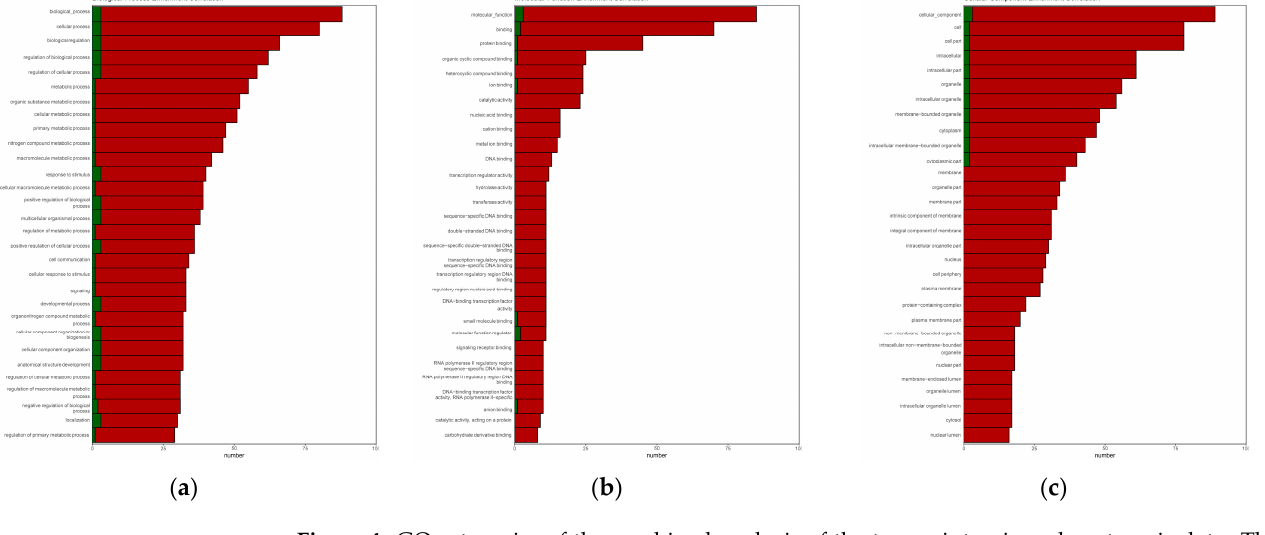
Figure 4. GO categories of the combined analysis of the transcriptomic and proteomic data. The differentially expressed molecules were classified into biological process ( a ), molecular function ( b ), and cellular component ( c ). The ordinate serves as the GO terms, and the abscissa indicates the number of the differentially expressed genes annotated to GO terms. The green bars represent differentially expressed genes, whereas the red bars represent differentially expressed proteins. Table 1. KEGG pathway enrichment analysis in combination with the transcriptomic and proteomic data.